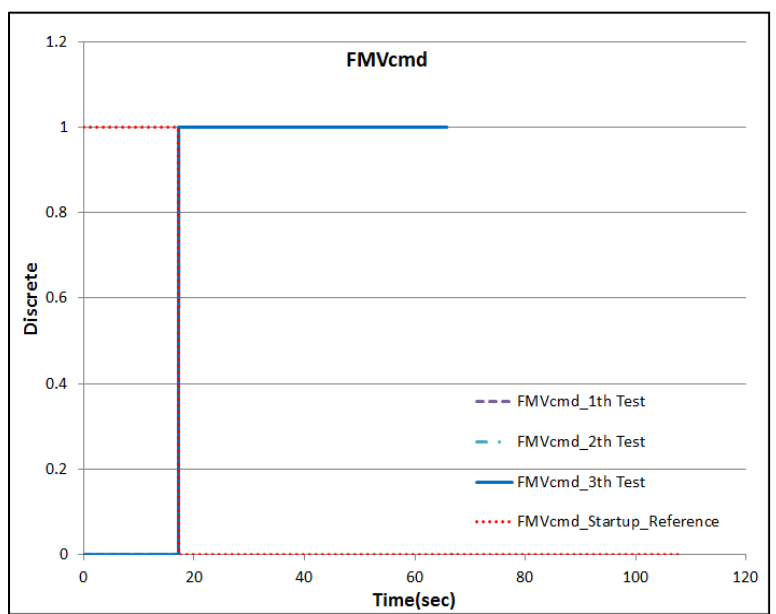
Figure 14. Result of EECU control logic verification test (FMVcmd).